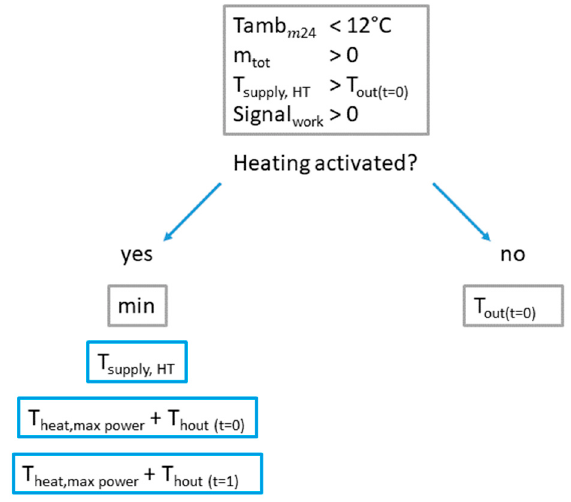
Figure 6. Heating scheme set-up (own representation).